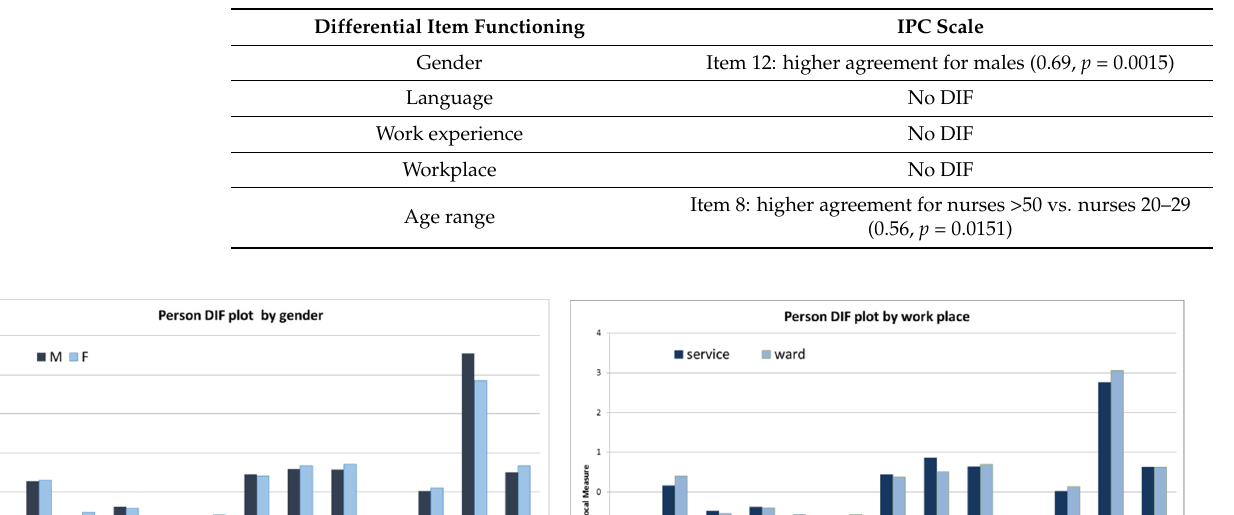
Table 5. Differential item functioning results for the IPC scale.